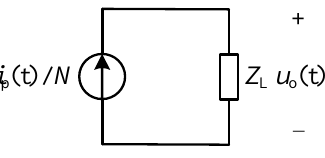
Figure 2. Ideal circuit model of CT.